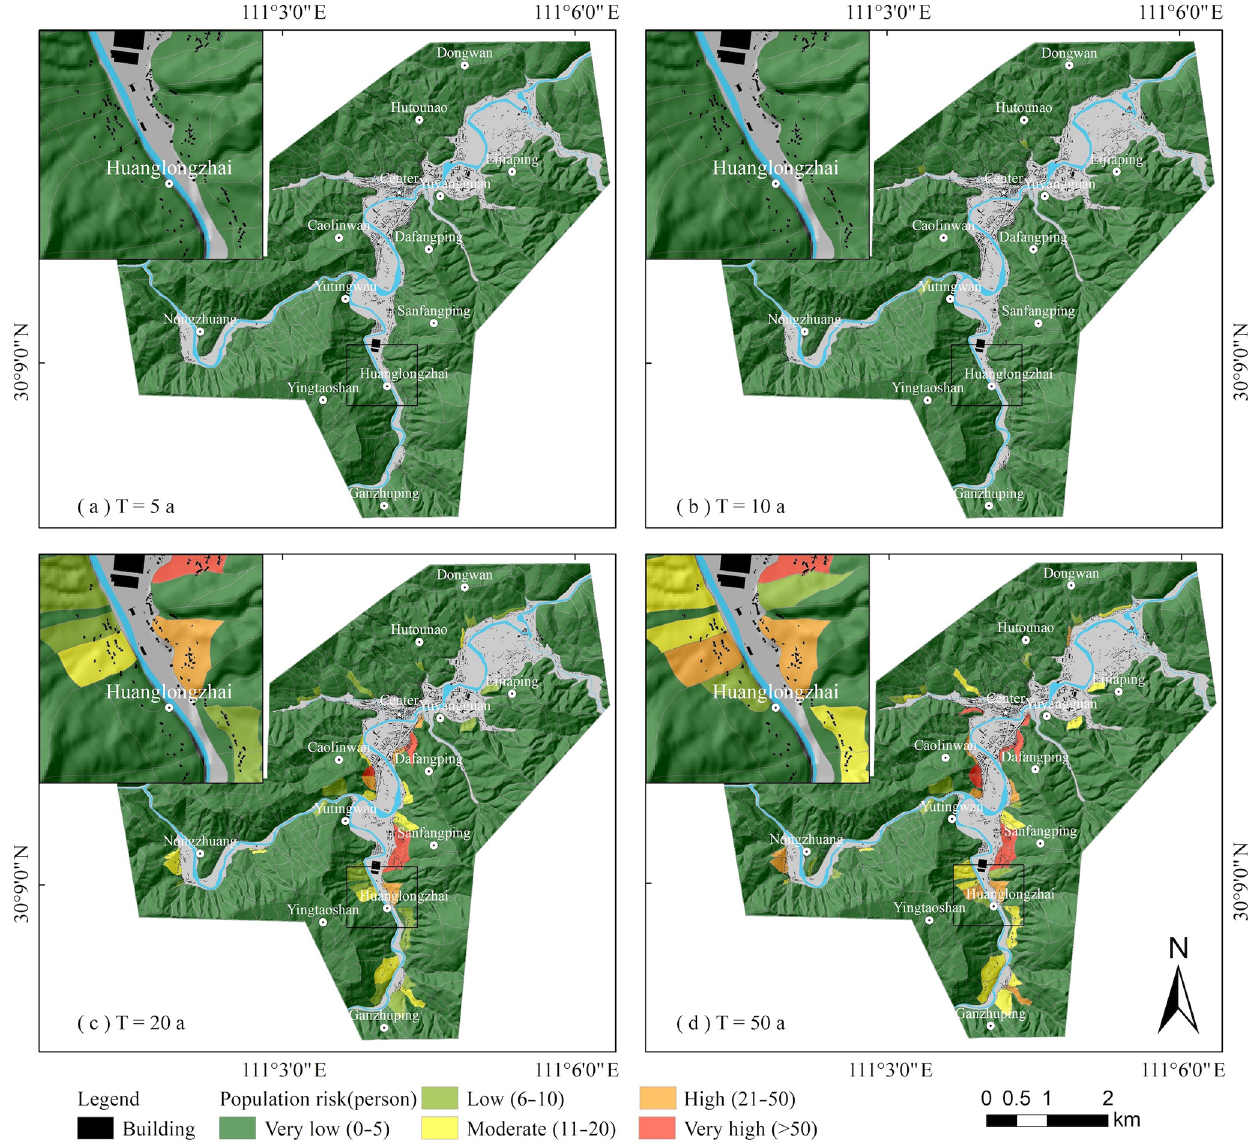
Figure 15. Example of a risk map for population loss for four return periods (5, 10, 20, and 50 years) and the landslide size scenario equal to or greater than 50000m 3